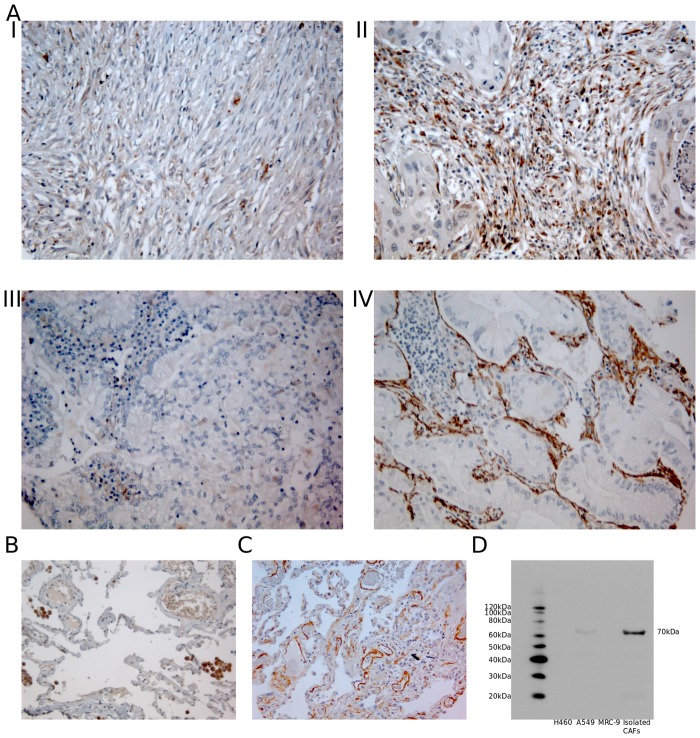
A) IHC analysis of TMA cores from NSCLC patients representing different stromal cell scores for expression of FAP-1 and α-SMA. I) Low stromal FAP-1; II) High stromal FAP-1; III) Low stromal α-SMA; IV) High stromal α-SMA. B) TMA control of healthy lung tissue showing strong FAP-1 positivity in normal lung macrophages, C) TMA control of healthy lung tissue showing some weak to intermediate α-SMA staining, D) Western blot for FAP-1 showing one clear 70 kDa band. Abbreviations: FAP-1, Fibroblast activating protein; α-SMA, alpha-smooth muscle actin.